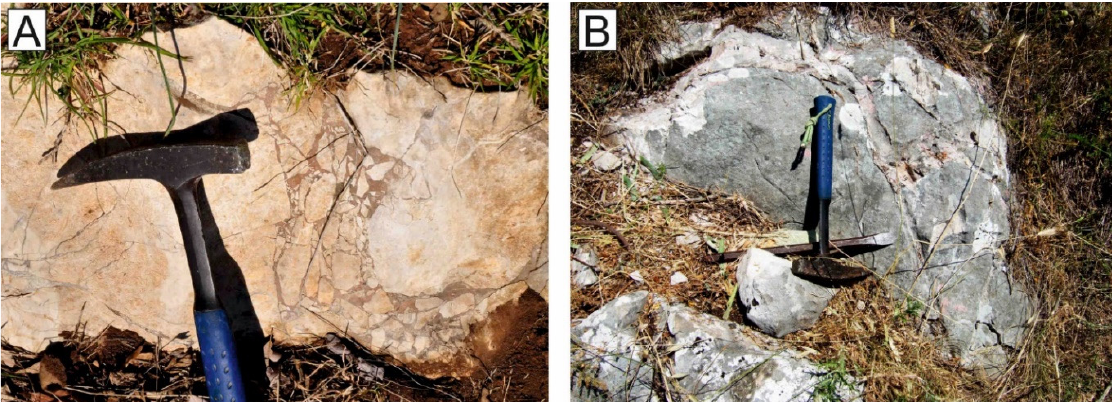
Figure 7. ( A ) The Cretaceous unconformity in the eastern sectors of South Western Prenestini (Colle Pompeo outcrop) shows karst features represented by breccias and red soil infilling fractures; ( B ) detail of pelagites infilling fractures developed on the Cretaceous platform substrate in the South Eastern